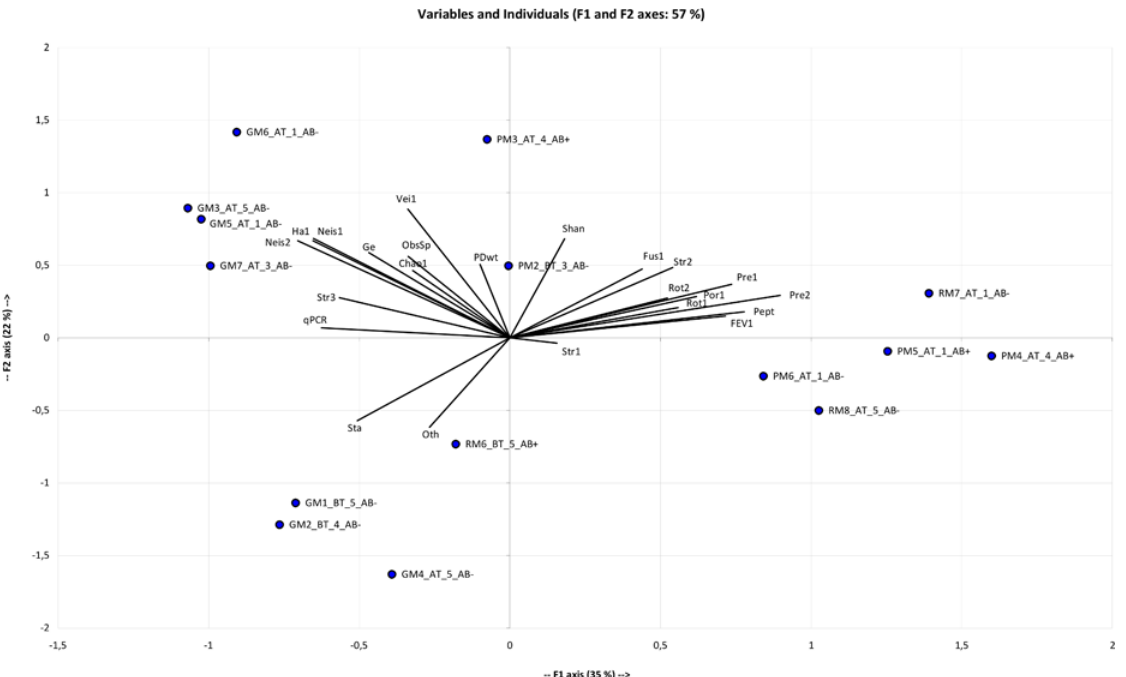
Fig 3. Principal component analysis (PCA) of the 20 sputum samples according to different quantitative variables. For each sample, the name contained the group (BT: before ivacaftor treatment; AT: after the beginning of ivacaftor treatment), cytologic class (1 to 5) and presence (AB+) or absence (AB-) of antibiotic treatment. The F1 and F2 axes explained respectively 35% and 22% of the variability. Only 15 samples are represented, because FEV-1 data were lacking for 5 samples (Table 1). The F1 axis was positively correlated with FEV-1, Peptostreptococcus (Pept), Prevotella 1&2 (Pre1&2), Porphyromonas 1 (Por1), Rothia 1&2 (Rot1&2) and Streptococcus 2 (Str2). These variables also correlated positively with each other, suggesting that these taxa may be positively correlated with FEV-1 improvement. In contrast, the F1 axis correlated negatively with qPCR, Haemophilus 1 (Ha1), Neisseria 1&2 (Neis1&2), Staphylococcus aureus (Sta) and Streptococcus 3 (Str3), indicating that these taxa may be more abundant and with higher bacterial density when respiratory capacity is lower. The F2 axis opposed S . aureus and OTUs not belonging to the core microbiota (Oth) to Veillonella (Veil), Neisseria 1&2, Haemophilus 1, Gemella (Ge) and higher diversity indices (Shannon index (Shan), phylogenetic diversity whole tree (PDwt) and observed species (ObsSp)).